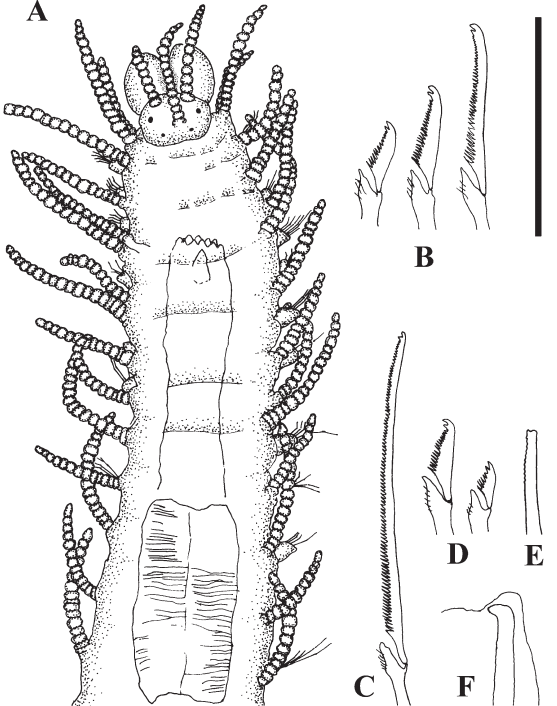
Fig . 10. – Syllis rosea . (A) Anterior end, dorsal view; (B) Ante- rior chaetae; (C) Mid-posterior pseudospiniger chaetae; (D) Mid- posterior falciger chaetae; (E) Posterior simple dorsal chaetae; (F) Posterior aciculae. Scale bars: A, 500 µm; B-F, 50